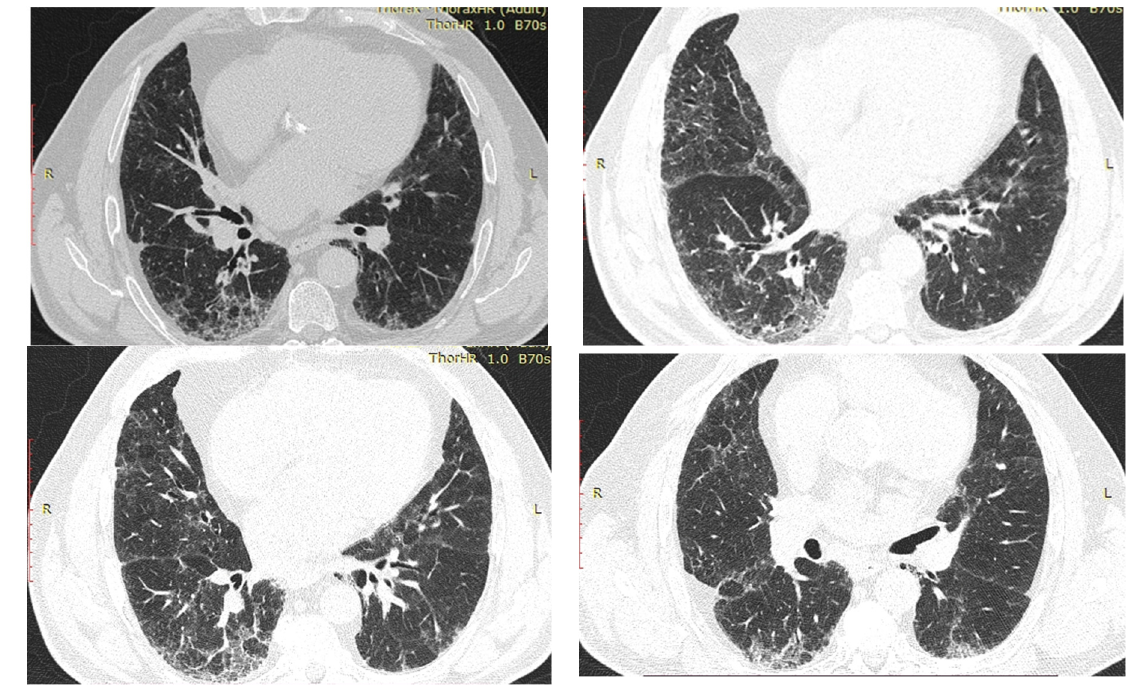
Figure 5. HRCT—2021—Case 2. Reticulation plaques, traction bronchiectasis, subpleural air micro- cysts. No honeycombing. Probable UIP pattern.